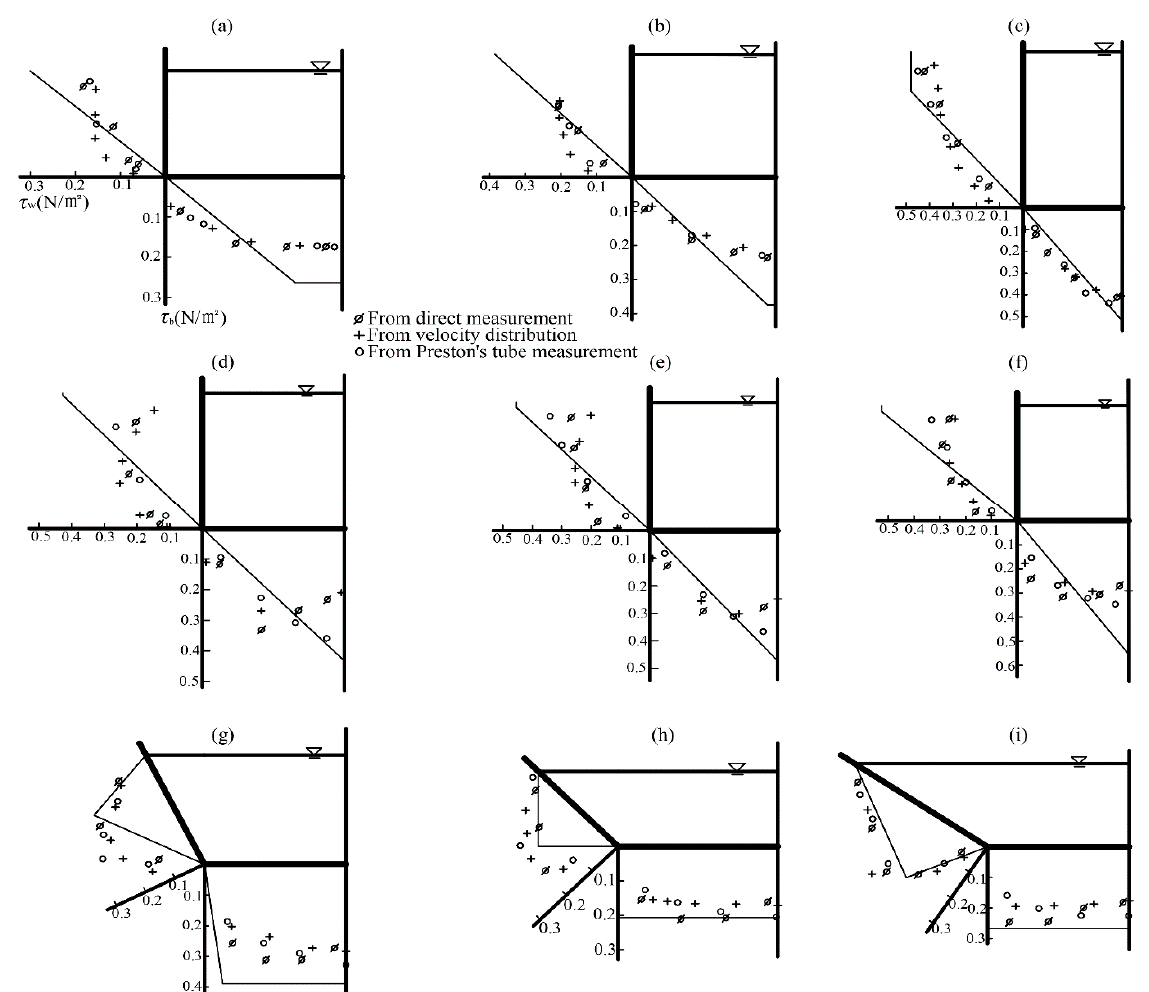
Figure 6. Comparisons of the calculated (denoted by fine lines) and measured boundary shear stress distribution: ( a ) Smooth, θ = 90° and P b / P w = 1.56; ( b ) Smooth, θ = 90° and P b / P w = 1.09; ( c ) Smooth, θ = 90° and P b / P w = 0.6; ( d ) Rough ( k s = 1.04 mm), θ = 90° and P b / P w = 0.98; ( e ) Rough ( k s = 1.85 mm), θ = 90° and P b / P w = 0.92; ( f ) Rough ( k s = 3.17 mm), θ = 90° and P b / P w = 0.9, ( g ) Rough ( k s = 3.17 mm), θ = 63.4° and P b / P w = 1.09; ( h ) Rough ( k s = 3.17 mm), θ = 45° and P b / P w = 1.41 ( i ) Rough ( k s = 3.17 mm), θ = 33.7° and P b / P w = 0.89.